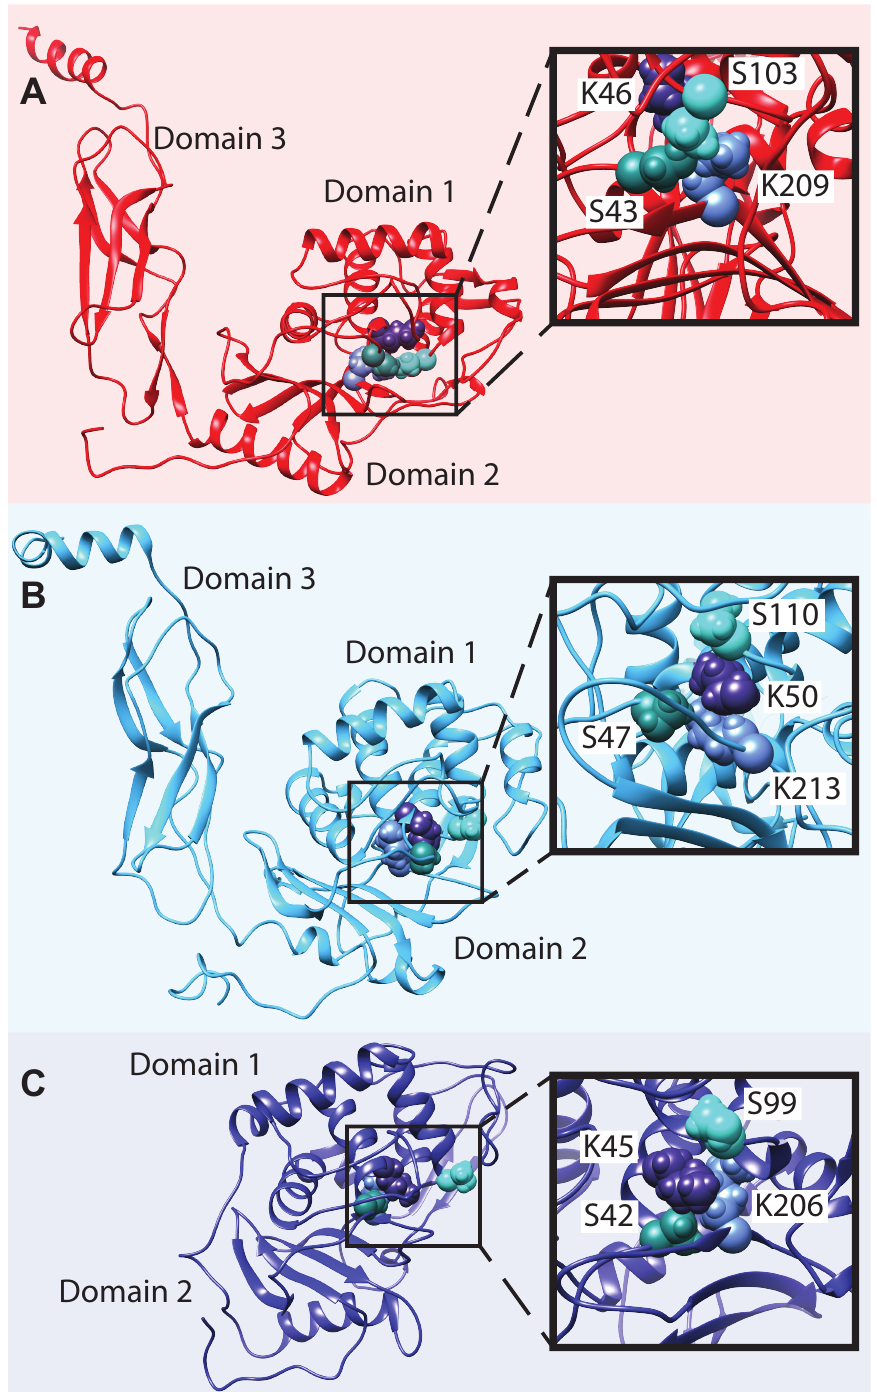
Figure 4. Representative structures of bacterial S11 proteases. The structures chosen are for the proteases representing the centroids of the three clusters shown in Figure 1. ( A ) Q5KXJ0_GEOKA, ( B ) A0A119D0G3_SHEFR, and ( C ) A0A106BYZ8_SHEFR. The insets of each panel show the active site residues, including the catalytic SKS triad (labeled in dark cyan, dark blue, and light cyan, respec- tively), as well as the additional K believed to be important in substrate binding and stabilization of the transition state (light